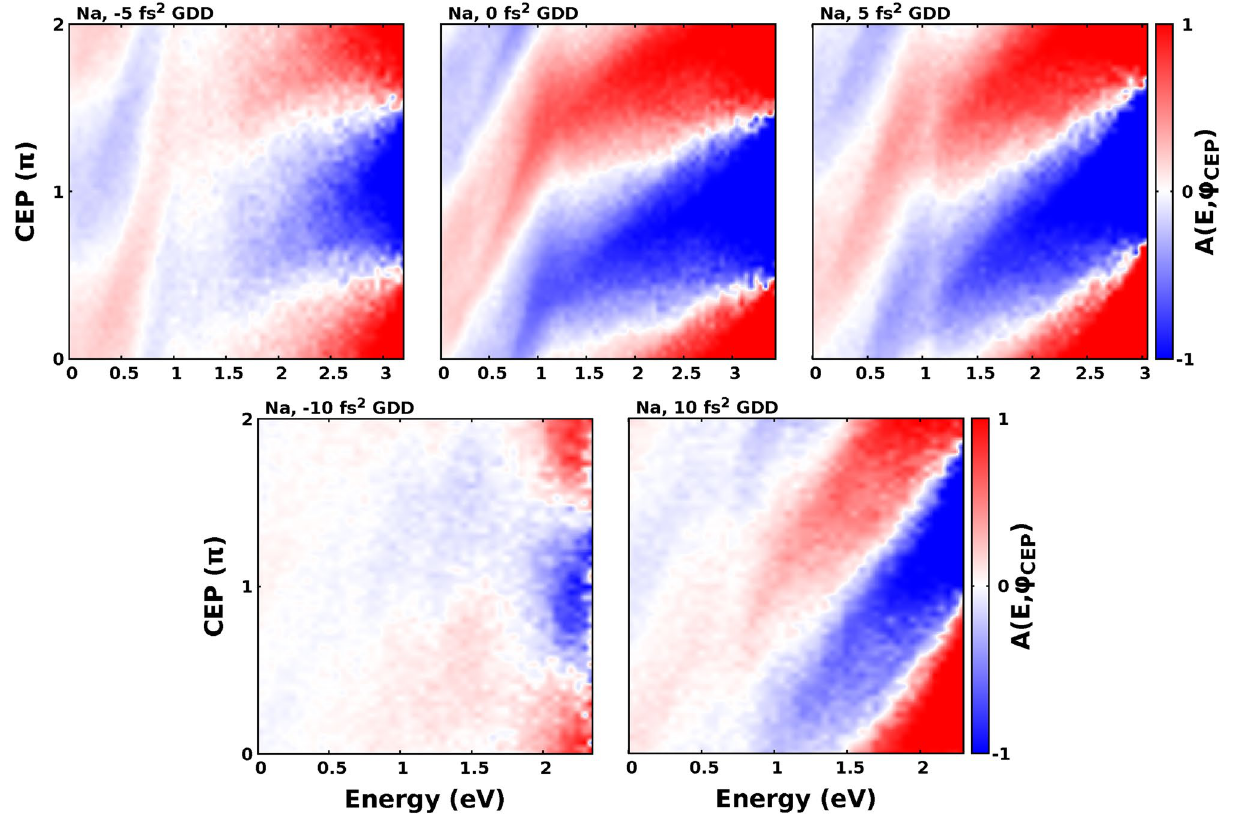
10 12 W / cm 2 intensity with ×